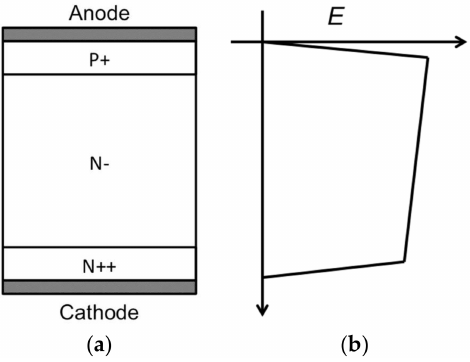
Figure 3. ( a ) A sketch of the power diode structure; and ( b ) the typical electric field distribution in the device in avalanche conditions along any vertical section of the active area of the